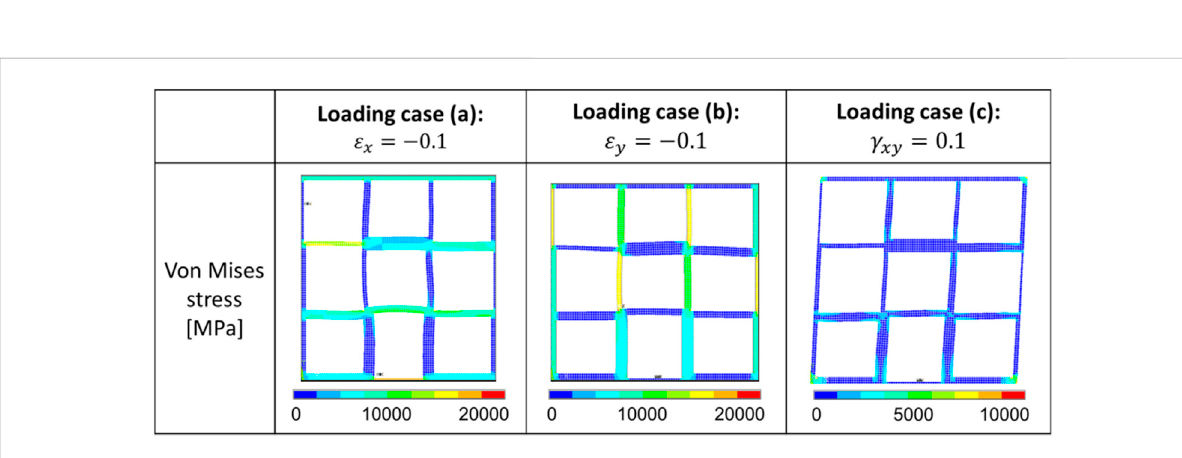
FIGURE 16 Distribution of the von Mises stress in one representative optimal scaffold under the three different loading